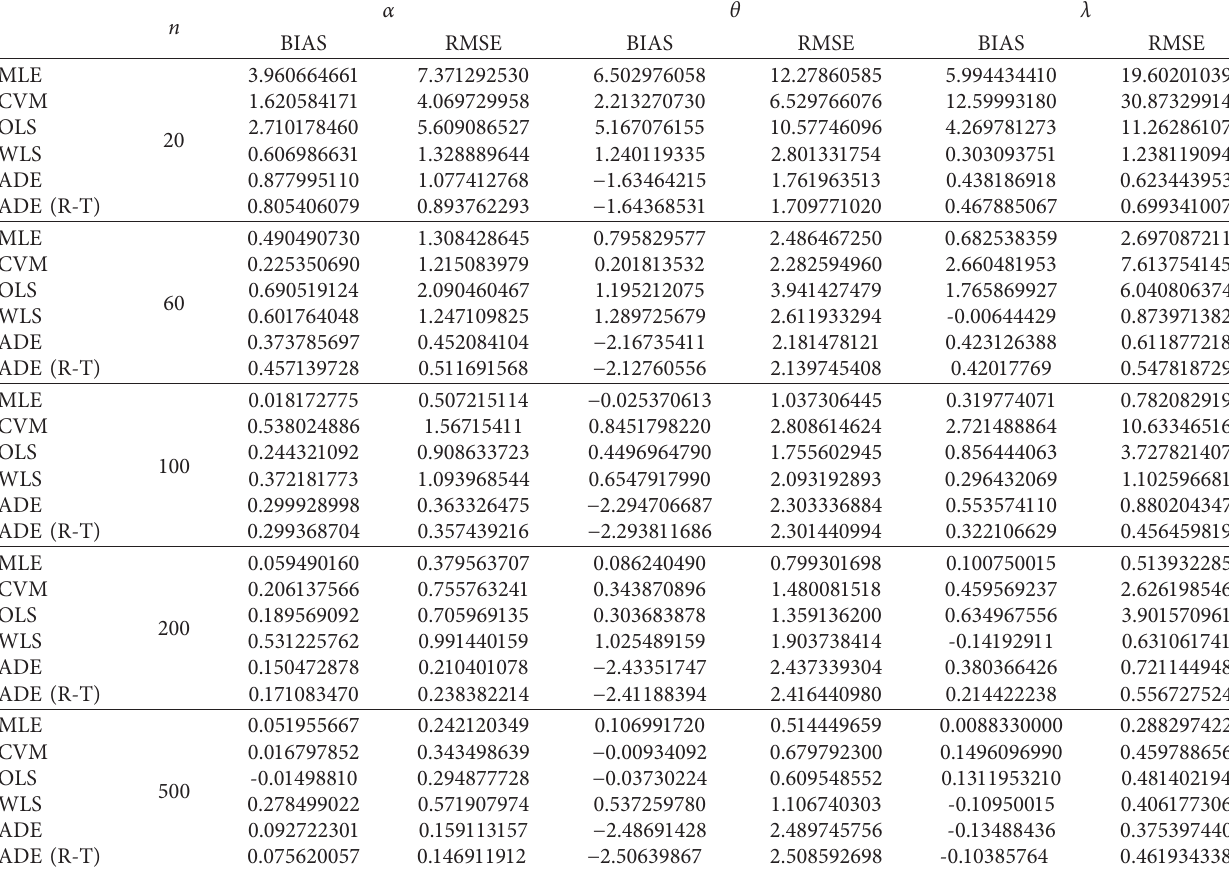
Table 2: Simulation study where the parameters α � 2 , θ � 3, and λ � 1 .